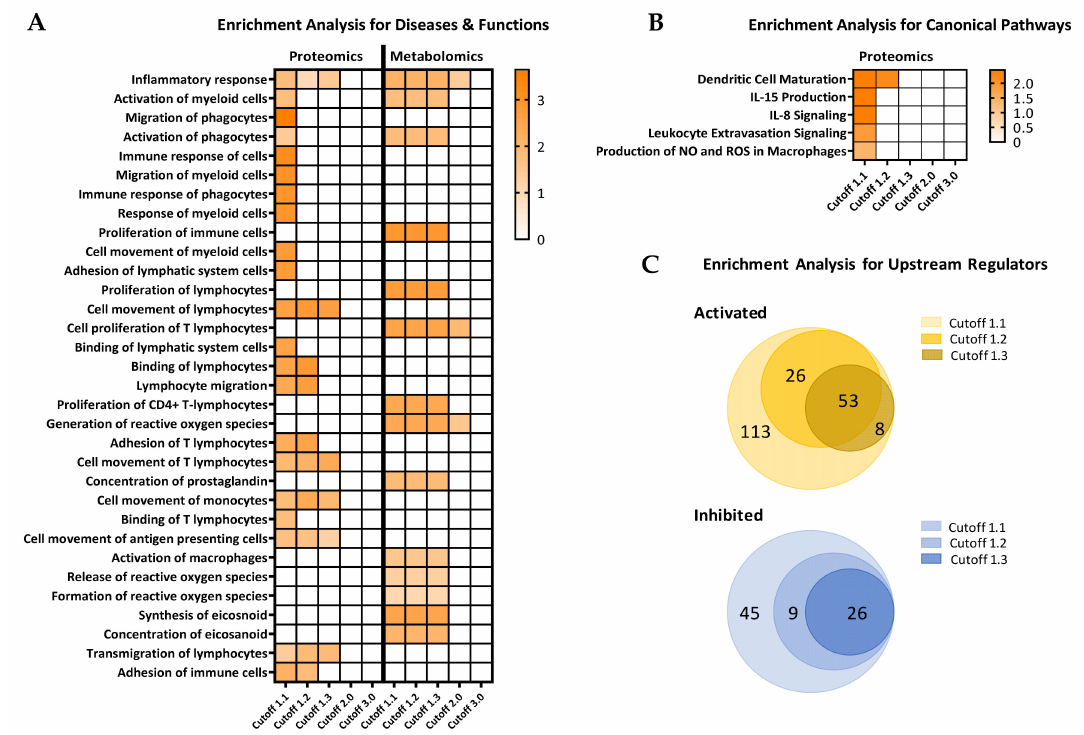
Figure 3. The ability to predict diseases and functions and alterations in canonical pathways and upstream regulators in high-risk T1D subjects decreases with increasing stringency of feature selection. Proteomics and metabolomics datasets with feature selection at different cutoff values were interrogated for predicted involvement in various immune inflammatory processes/pathways using the “Comparison Analysis” module of IPA software. ( A ) Diseases and functions predicted to be most affected in the high-risk T1D subjects compared to healthy controls by independent analyses in the proteomics and metabolomics datasets. ( B ) Canonical pathways analysis with increasing cutoff values for feature selection in the proteomics dataset. ( C ) Upstream regulator analysis in the proteomics, metabolomics, and lipidomics datasets, without curation for any specific physiological function at the indicated cutoff values, showing the total number of upstream regulators predicted to be activated and inhibited. Results in A and B are shown as heatmaps with the orange color indicating activation and its intensity the magnitude of the z -value (statistical score that accounts for the directional effect of change for functions or molecules in the experimental datasets; https://go.qiagen.com/IPA-transcriptomics-whitepaper, accessed on 16 February 2021). Results in C are shown as concentric Venn diagrams showing the number of activated (orange) or inhibited (blue) upstream regulators predicted in the analyses at the indicated cutoff values; no predictions were possible at cutoff values of 2.0 or